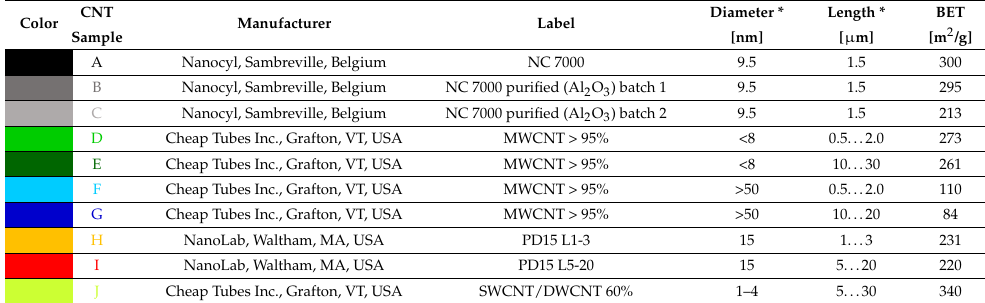
Table 1. CNT properties: length, diameter, and BET surface (measured